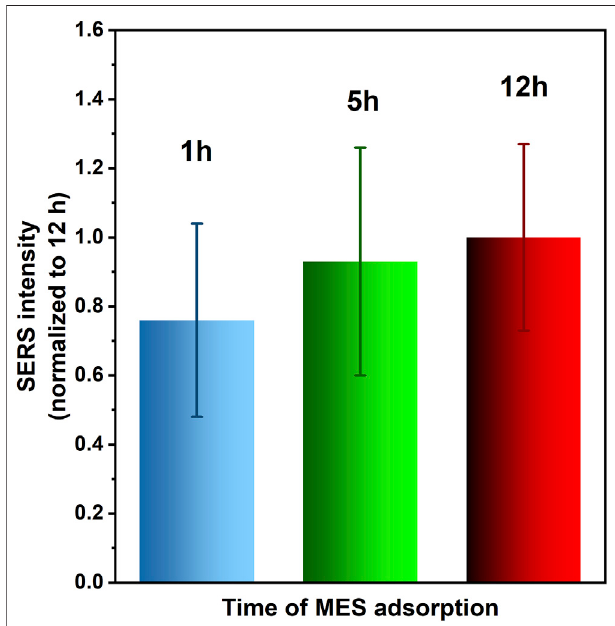
FIGURE 7 | Average intensity of MES SERS band around 790 cm − 1 vs time of MES adsorption (with error bars showing the RSD values). The results are normalized to the SERS intensity measured for 12 h time. Typically 25 – 36 spots localized across 60 – 80 μ m x 100 – 120 μ m rectangular area were analysed in each case.